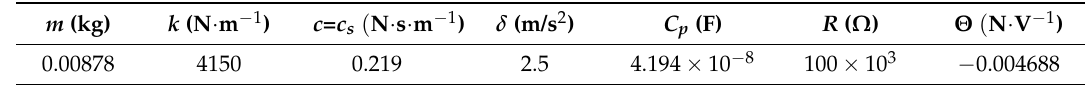
Table 1 . System parameters [23]. Table 1. System parameters [23].